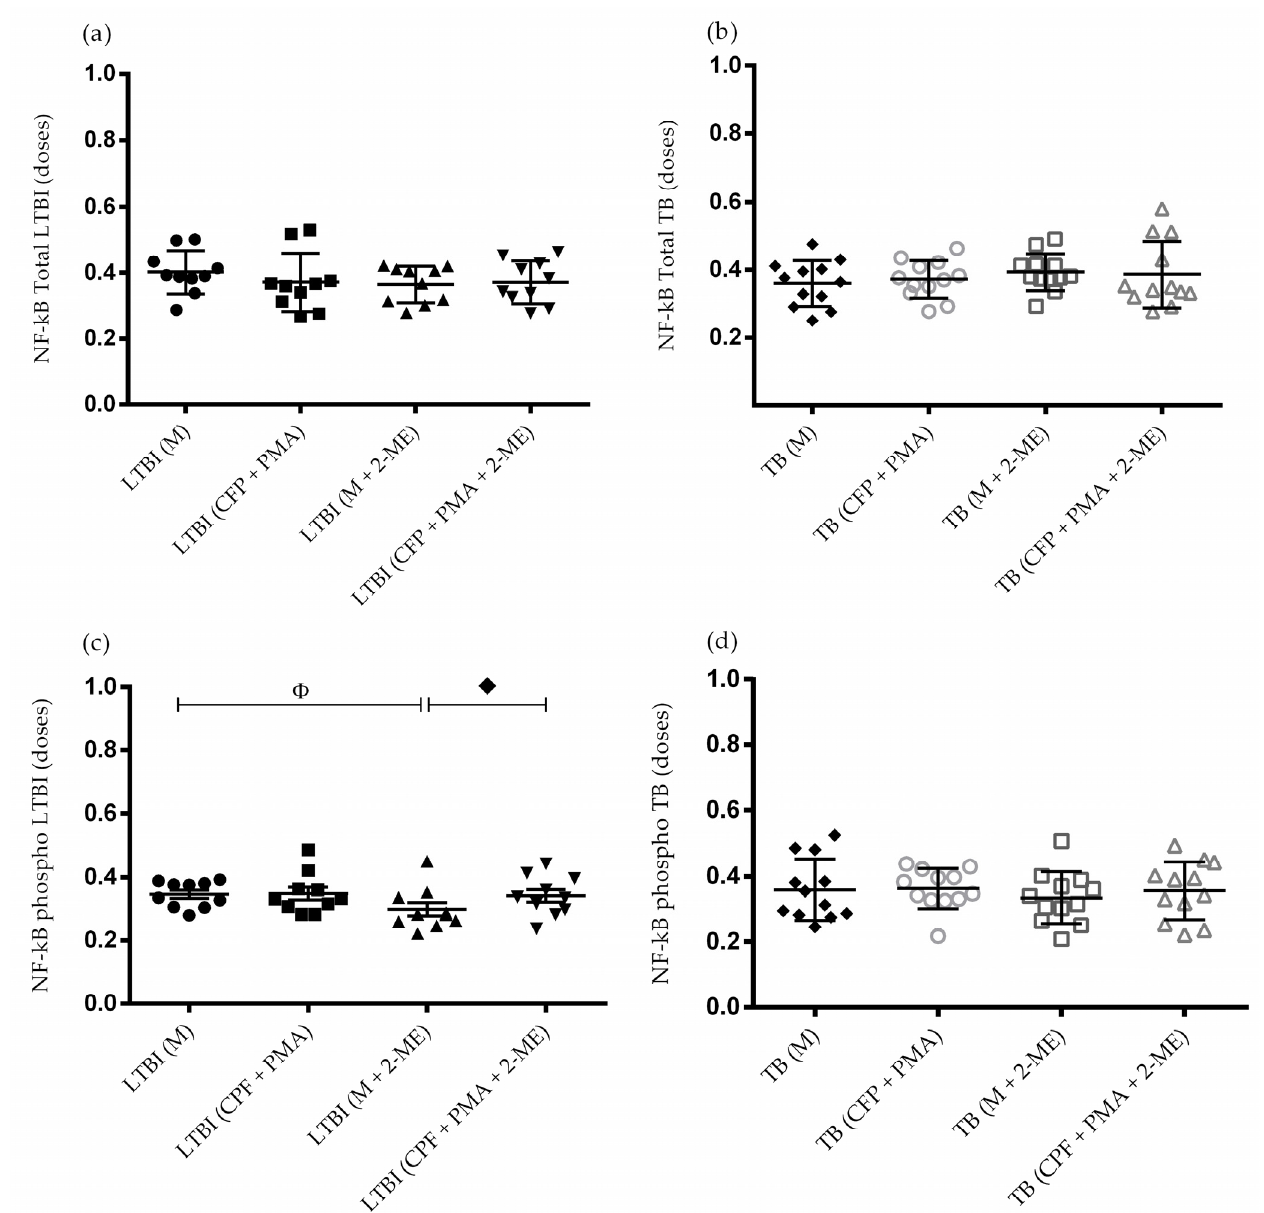
Figure 3. Total and phosphorylated nuclear factor kappa B (NF- κ B) levels of healthy controls, individuals with LTBI, and patients with active TB. Total and phosphorylated NF- κ B levels in lysates of PBMCs were evaluated using a sandwich ELISA-based kit after stimulation with culture filtrate protein (CFP) + (phorbol 12-myristate 13-acetate) PMA, under normal conditions and HIF-1 α blockade with 2-methoxyestradiol (2-ME). Levels of total NF- κ B in ( a ) individuals with LTBI and ( b ) patients with TB; there was no statistical difference between the groups after HIF-1 α blockade. ( c ) Levels of phosphorylated NF- κ B in cell lysates of PBMCs from individuals with LTBI cultured under different conditions. Φ p = 0.0469 for medium + 2-ME versus medium alone; ♦ p = 0.0371 for CFP + PMA + 2-ME versus medium + 2-ME. ( d ) Levels of phosphorylated NF- κ B in cell lysates of PBMCs from patients with TB cultured under different conditions; there was no statistical difference between the groups after HIF-1 α blockade. Data are presented as the mean ± (SD) and represent one of three independent experiments. Statistical analysis was performed using ANOVA and post hoc t -test, with a significance of p < 0.05. Abbreviations: pNF- κ B, phosphorylated NF- κ B; M, medium; CFP, culture filtrate protein; PMA = phorbol 12-myristate 13-acetate; 2-ME, 2-methoxyestradiol.